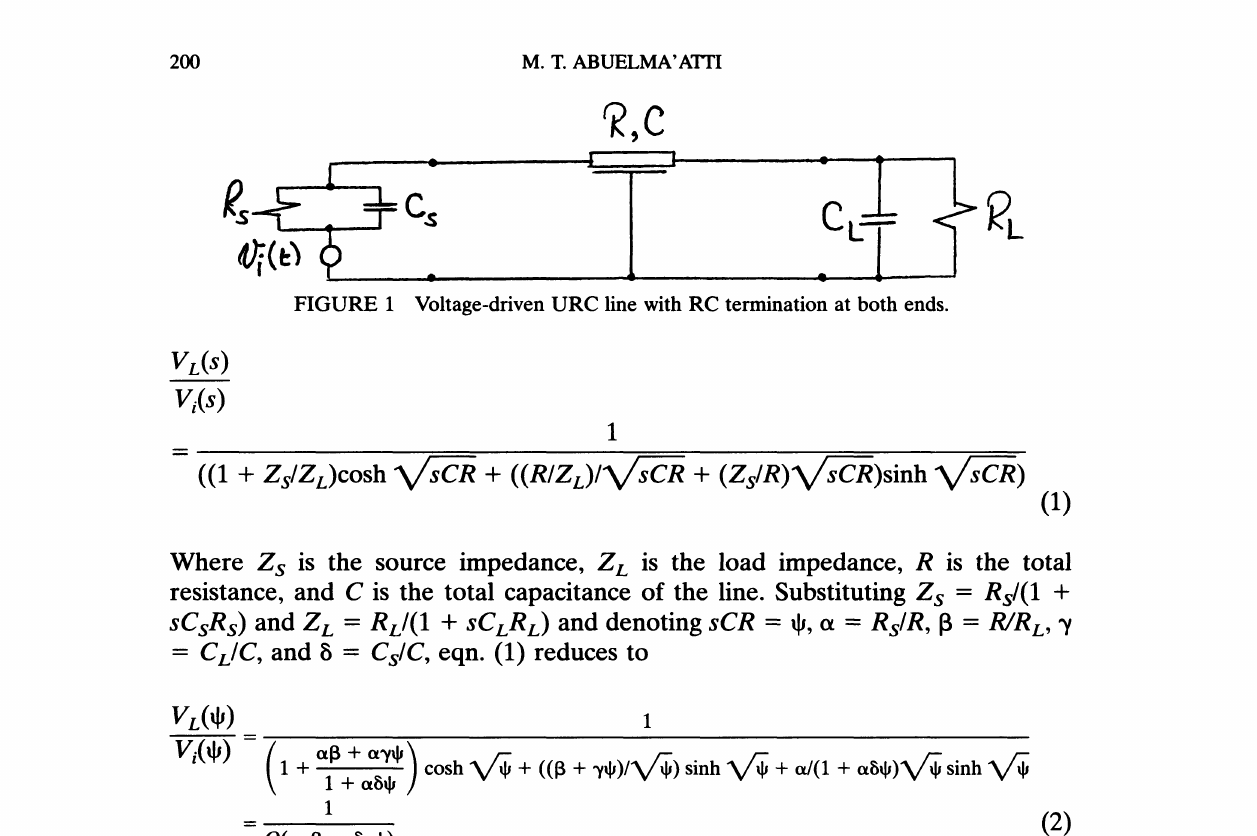
FIGURE 1 Voltage-driven URC line with RC termination at both